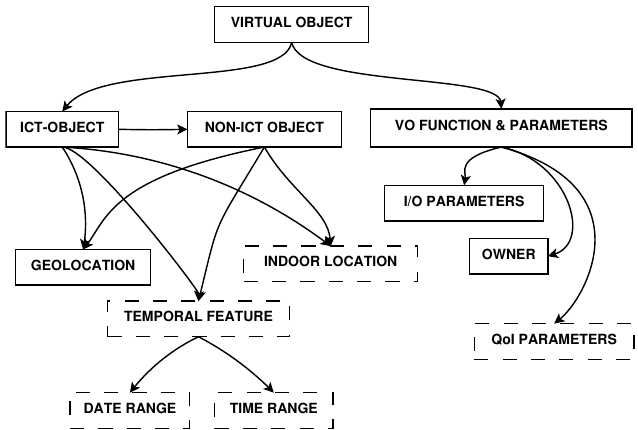
Figure 2. Virtual Object Information Model used. Solid border boxes correspond to elements included in the iCore VO Information Model. Dashed border boxes are new elements introduced by the proposed